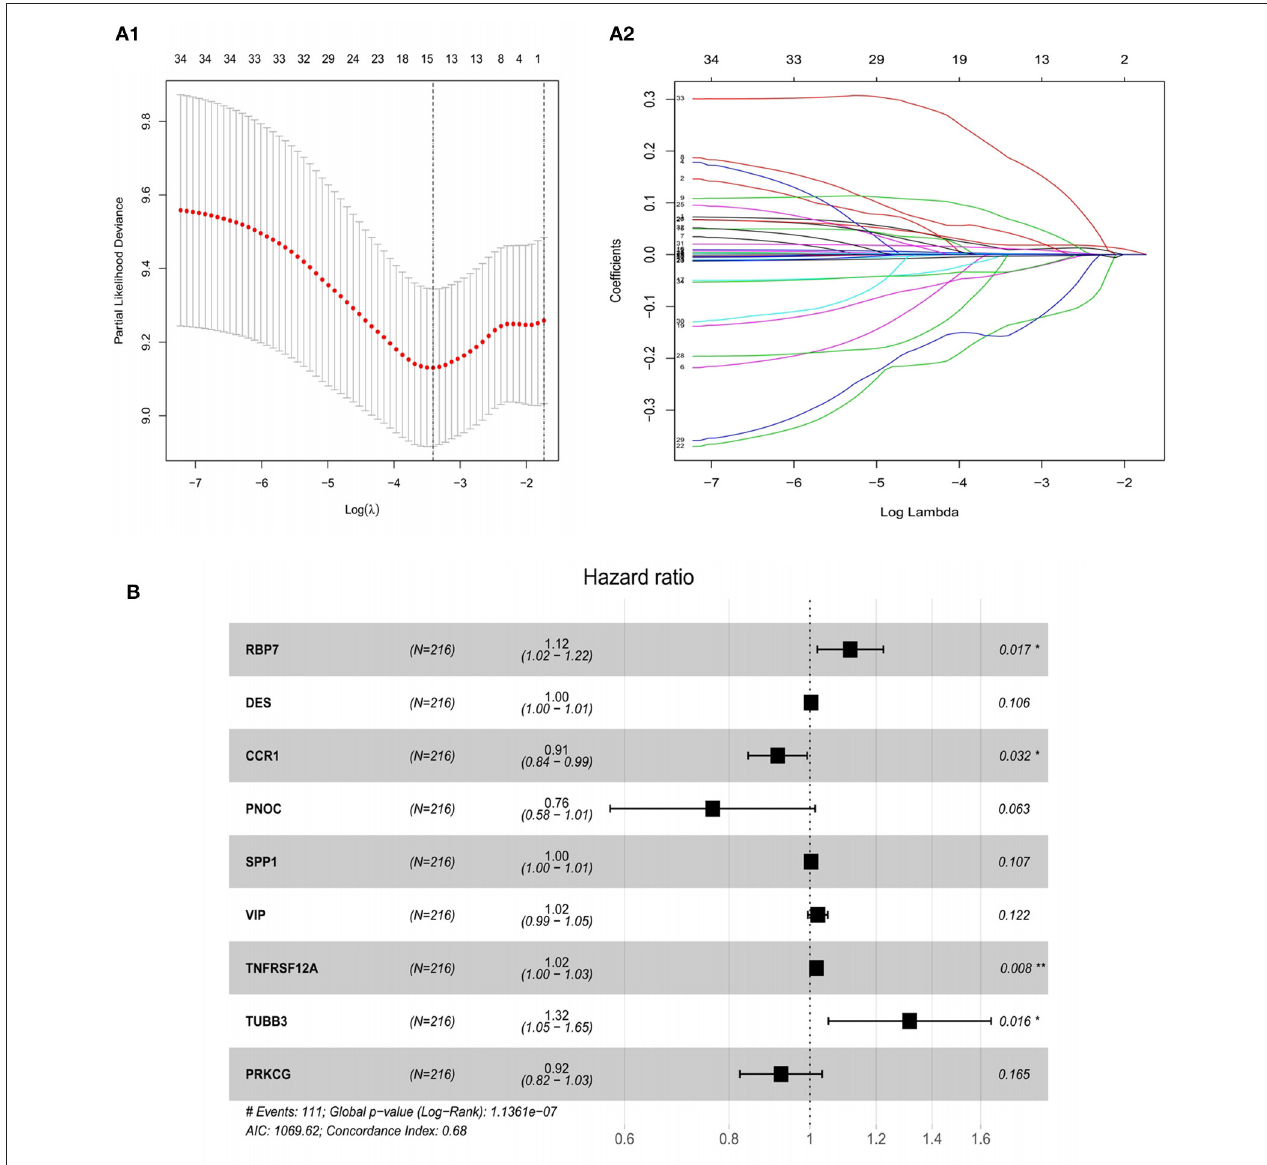
FIGURE 4 | Construction of a risk assessment model by Lasso and Cox regression analysis in the training group. (A1) Selection of the optimal parameter (lambda) in the Lasso model for GC. (A2) Lasso coefficient profiles of genes in GC. A coefficient profile plot was generated against the log (lambda) sequence. (B) After optimization by Cox analysis, 9 mRNAs were selected to construct the risk assessment model as shown in the forest graph. ** P < 0.01; * P <